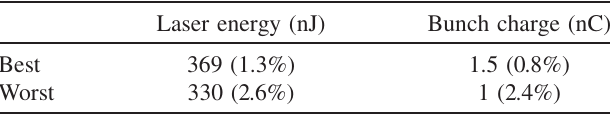
TABLE III. The best and the worst measured values for the laser and bunch amplitude stability during the commissioning.